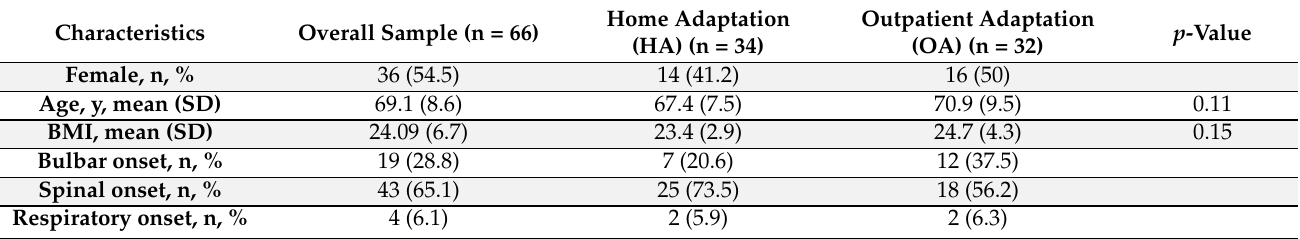
Figure 2. Flow chart of participant inclusion. Table 1. Baseline characteristics of the overall sample and both the experimental and the control